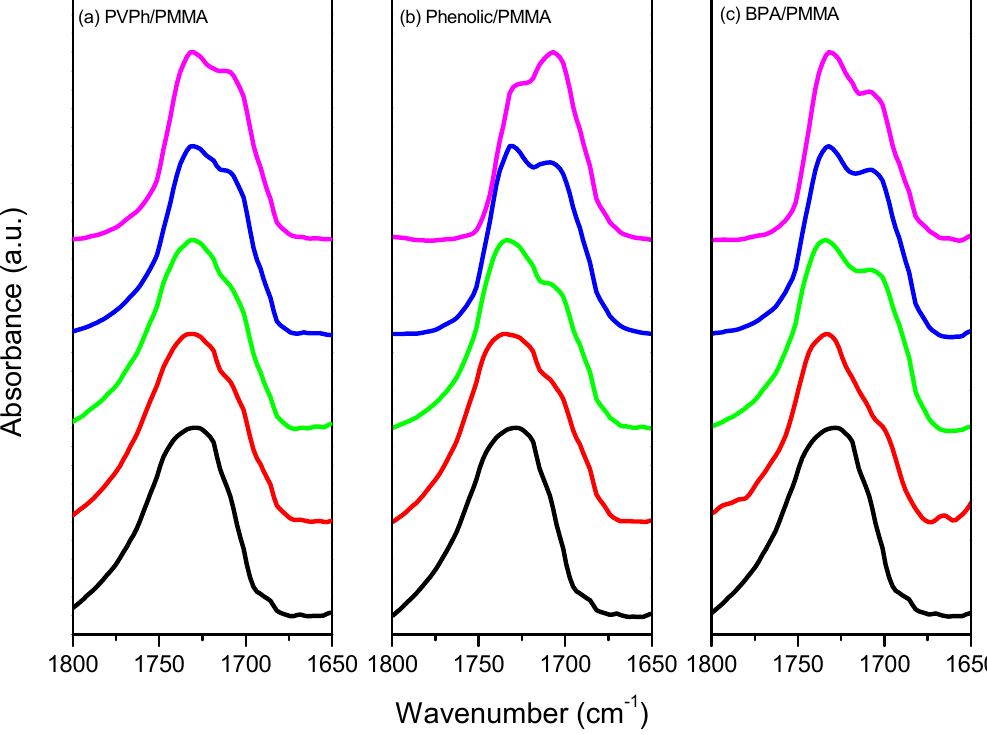
Figure 8. FTIR spectra (1800–1650 cm − 1 region) recorded at room temperature for ( a ) PVPh/PMMA; ( b ) phenolic/PMMA; and ( c ) BPA/PMMA blends containing various PMMA